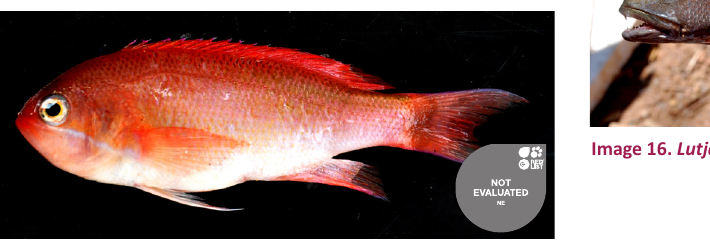
Image 15. Pseudanthias marcia